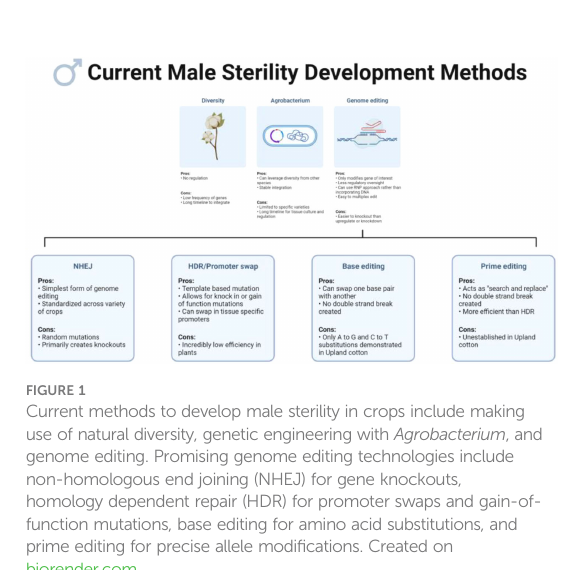
FIGURE 1 Current methods to develop male sterility in crops include making use of natural diversity, genetic engineering with Agrobacterium , and genome editing. Promising genome editing technologies include non-homologous end joining (NHEJ) for gene knockouts, homology dependent repair (HDR) for promoter swaps and gain-of- function mutations, base editing for amino acid substitutions, and prime editing for precise allele modi fi cations. Created on